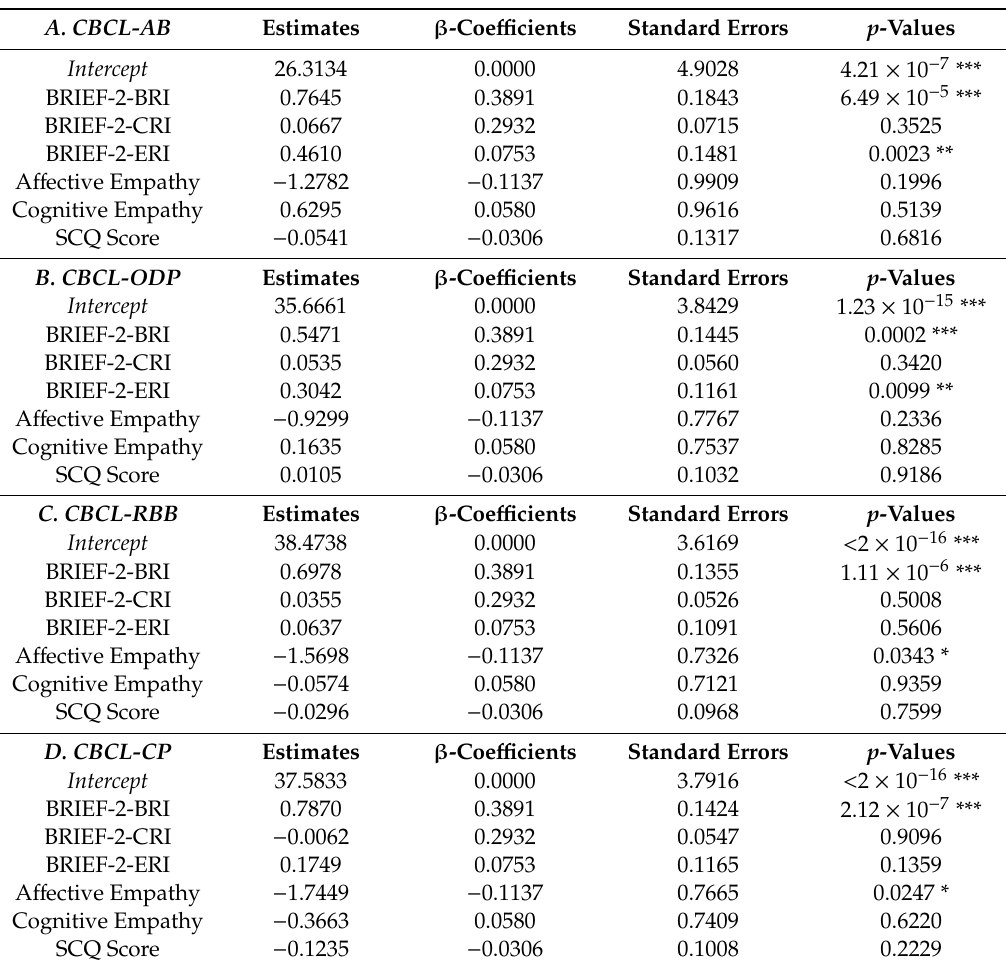
Table 1. Linear Regression